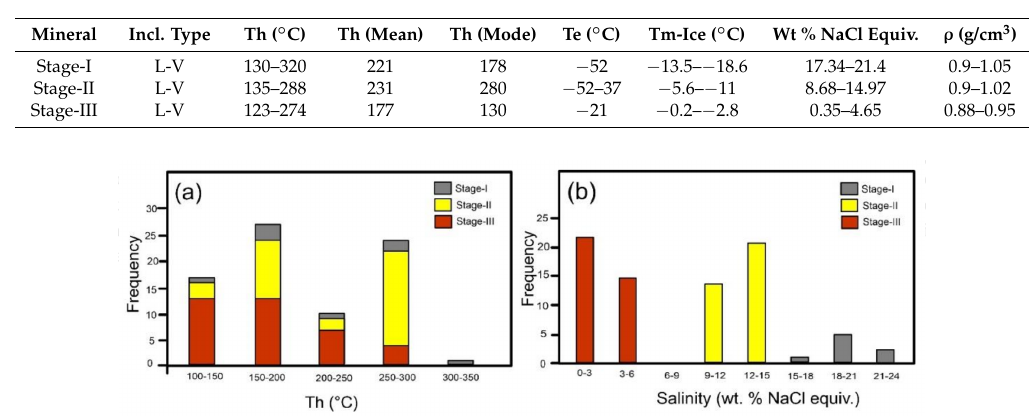
Table 6. Microthermometric data summary for LV fluid inclusions ( n = 80) from sphalerite of the Shah-Ali-Beiglou deposit.